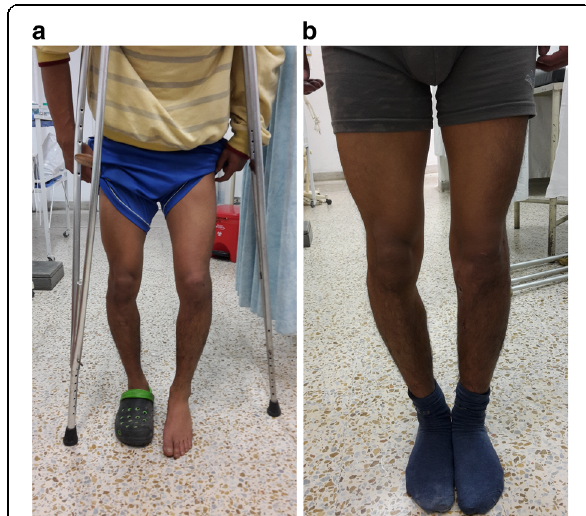
Fig. 19 a . High Varus deformity. b POP valgus